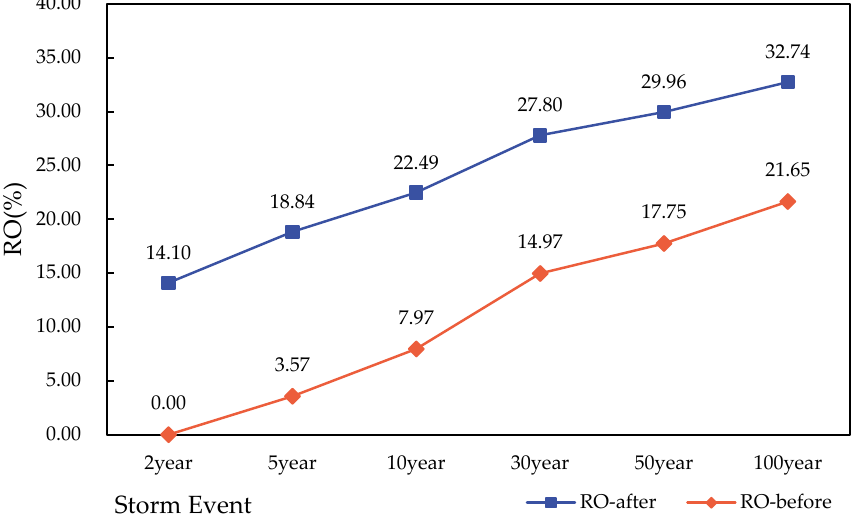
Figure 10. Rainfall–outflow ratio before and after the construction of the study area under different rainstorm events.